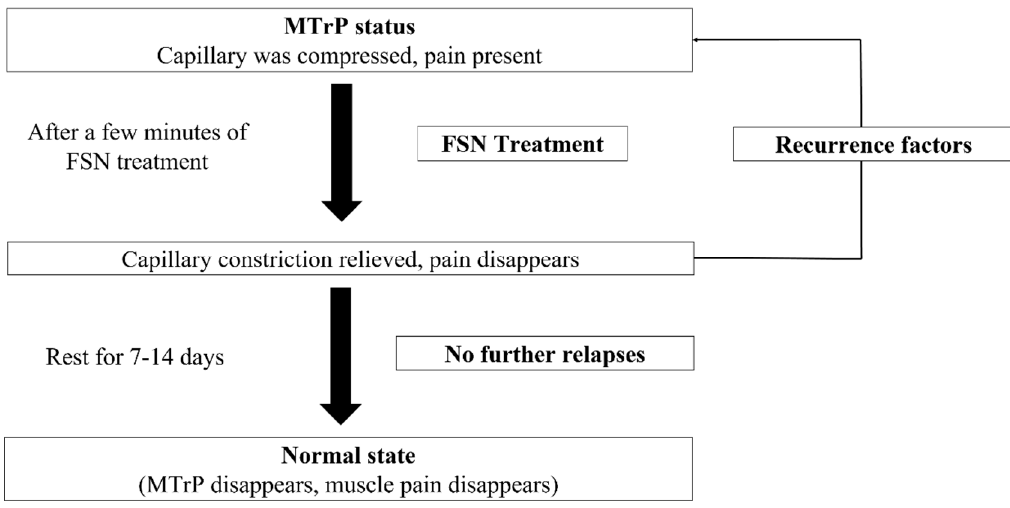
Figure 9. Improvement process for